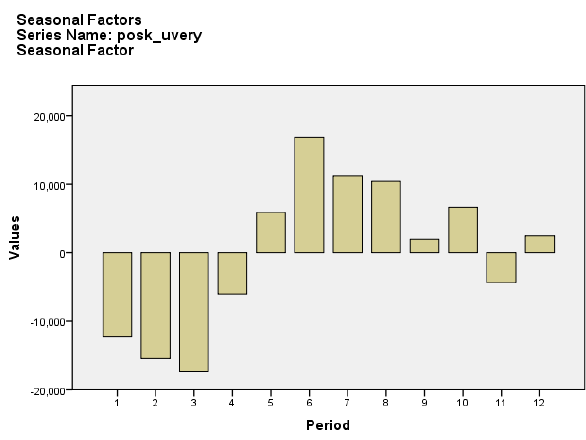
Figure 3. Seasonality is observed in provided credits.